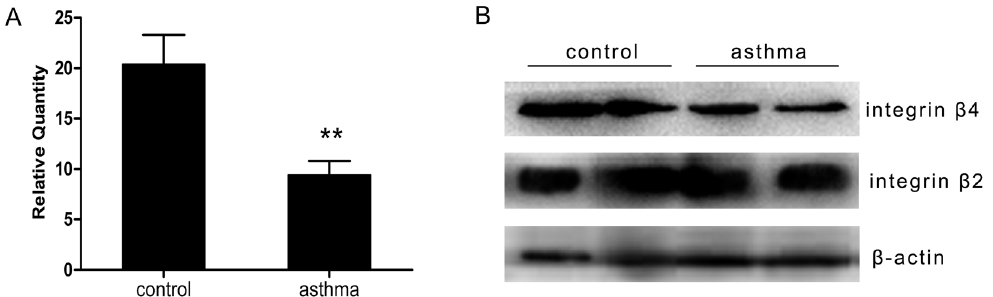
Figure 1. The intergrin b 4 expression in peripheral blood leukocytes of asthma patients. A: Intergrin b 4 mRNA expression assayed by real time PCR. Healthy control n=34, Asthma patients n=38. **P , 0.01 versus control. B: Intergrin b 4 protein expression assayed by western blot. Integrin